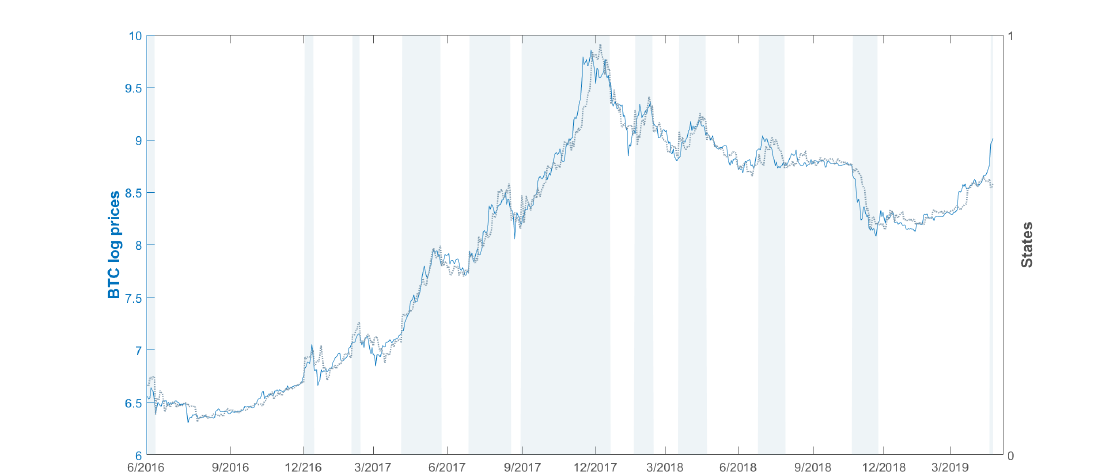
Figure 2. Logarithmic BTC prices series (blue line) and in-sample estimated logarithmic BTC price series for the period 6/2016–5/2019 (gray dotted line). Shaded bars mark times with hidden state 1 (smoothed probability above